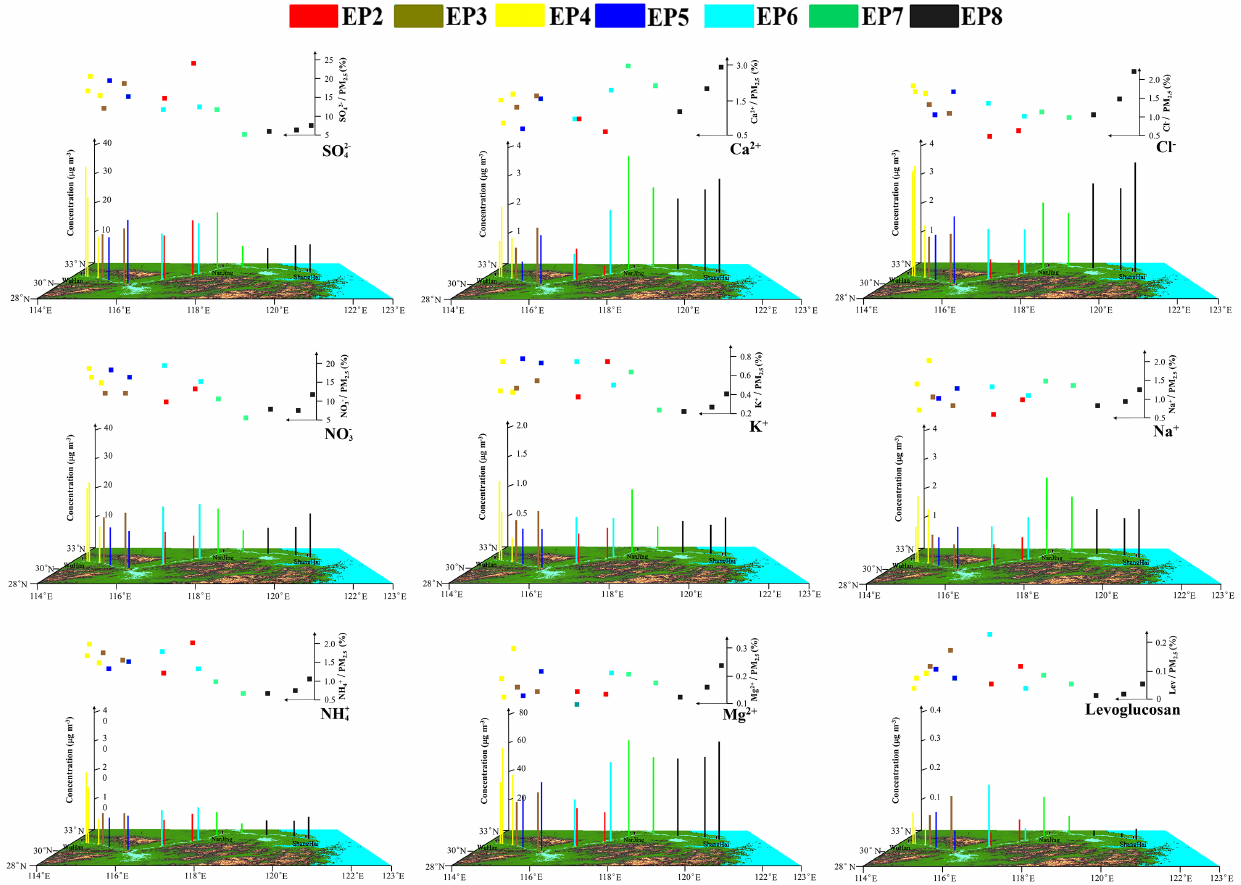
Figure 3. Spatial concentration distributions of the soluble ions and levoglucosan in PM 2 . 5 along the cruise